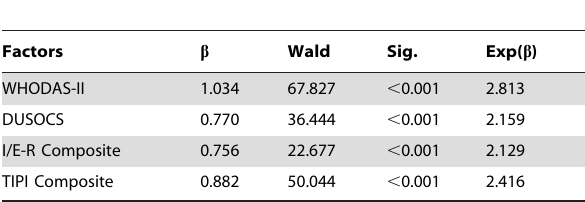
Table 3. Relevant statistics for the four factors from logistic regression